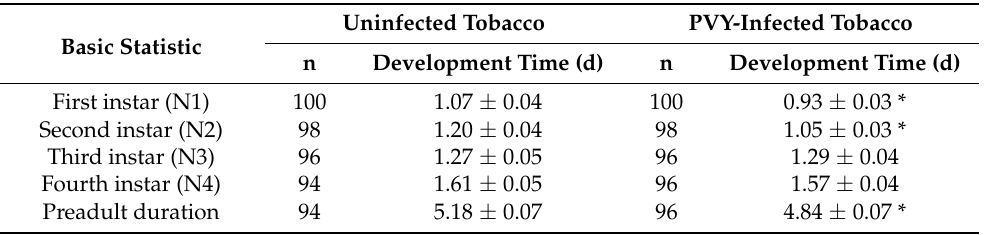
Table 2. Developmental time, adult longevity, APOP, TPOP, and fecundity of M. persicae on uninfected tobacco and PVY-infected